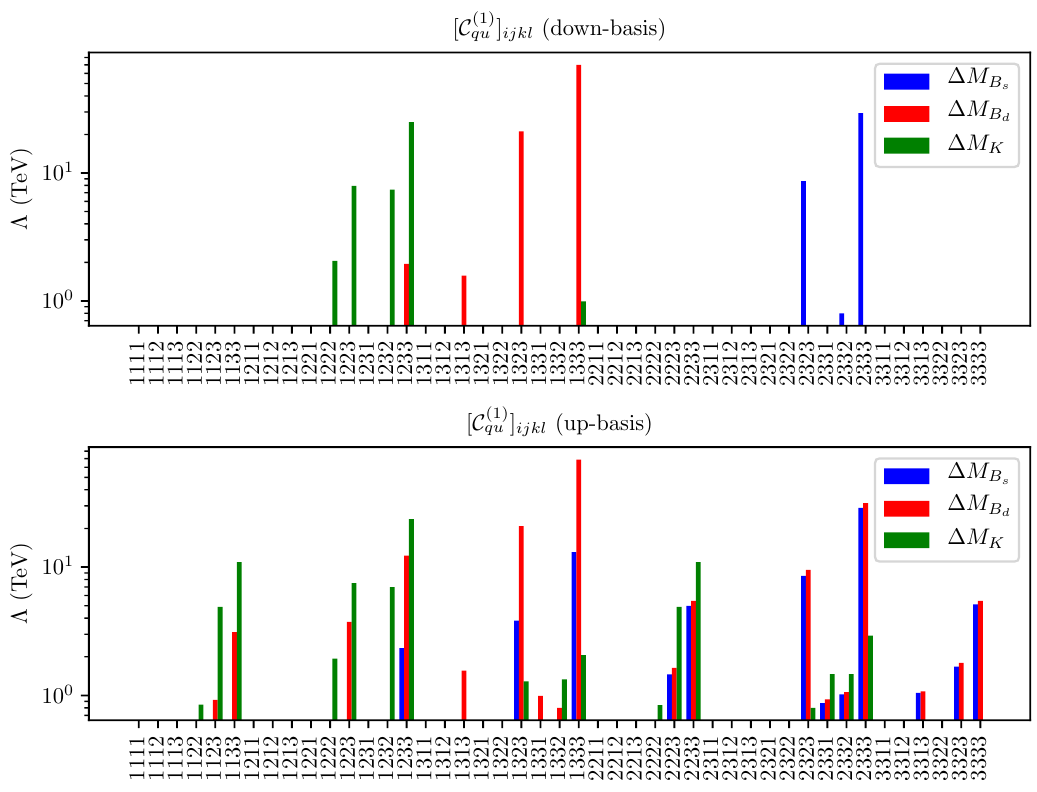
(cid:2) (cid:3) c (1) qu = 10 that corresponds to a 10% effect in ijkl